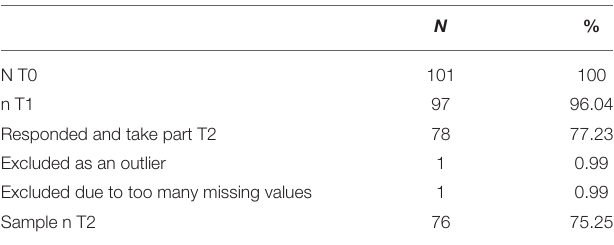
TABLE 1 | Flow of